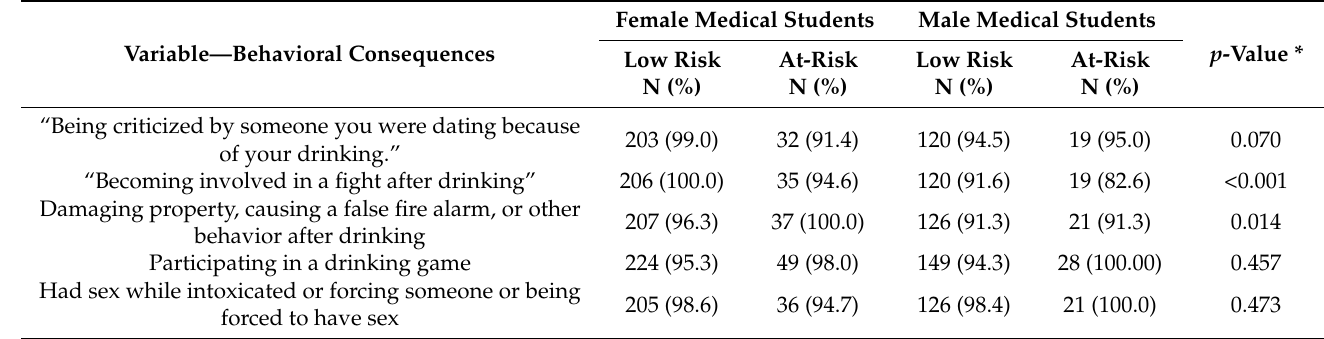
Table 6. Other problems related to drinking.